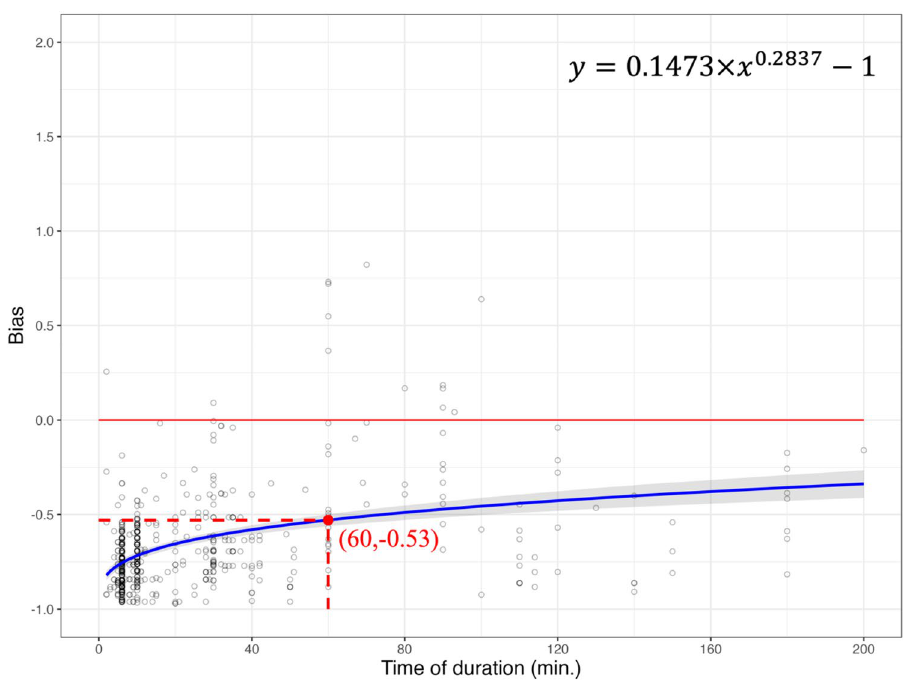
Figure 4. The relationship of duration on eBird checklists and bias. The power function (formula on the top right) estimated the non-linear relationship between duration and bias (blue solid line). Bias was derived from the results of observed species richness in eBird and average estimated species richness from BBS (black circle). Where bias = 0 (red solid horizontal line) indicates no differences among observed species richness from eBird and average estimated species richness from BBS, indicating eBird could record an average of 100% of the BBS species